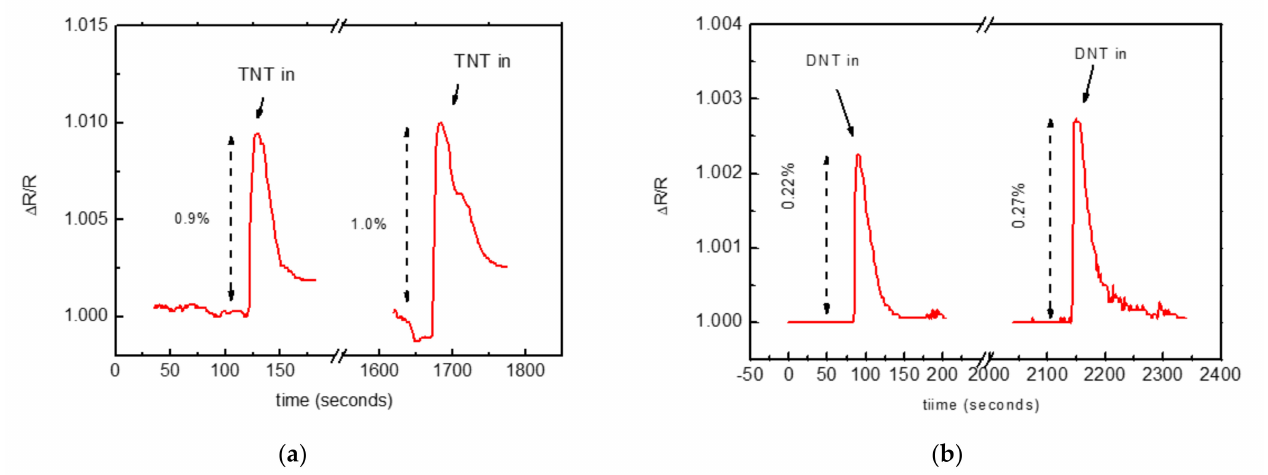
Figure 7. ( a ) Repeated changes in resistance of the NH 2 − C 2 − MWCNT based sensor under a rapid flux of TNT − saturated N 2 gas. ( b ) Repeated changes in resistance of the NH 2 − C 2 − MWCN -based sensor under a rapid flux of DNT − saturated N 2 gas. The sensor resistivity corresponded to 1.7 k Ω